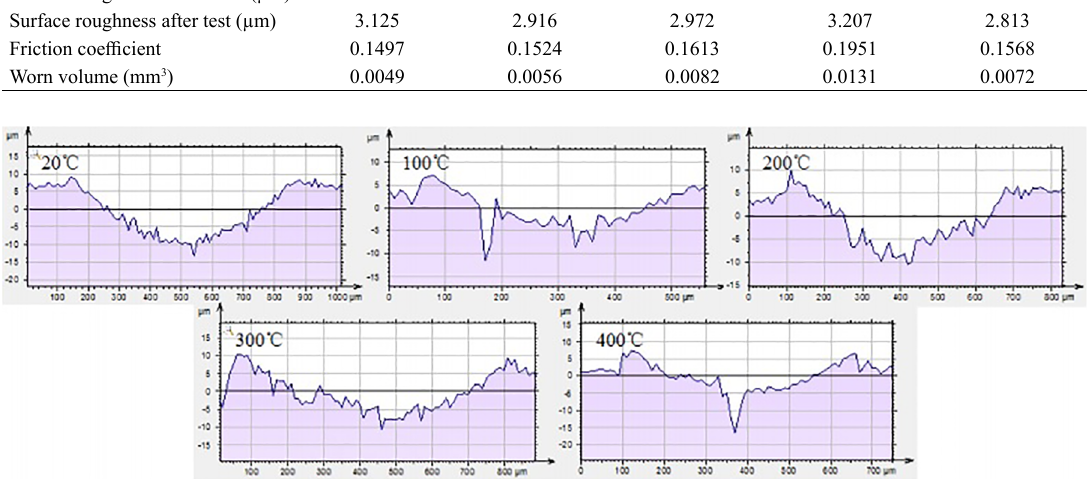
Figure 11. The deepest point and sectional view of the grinding marks on the 9Cr18Mo sample surface for the ceramic frictional pair and at different test temperatures